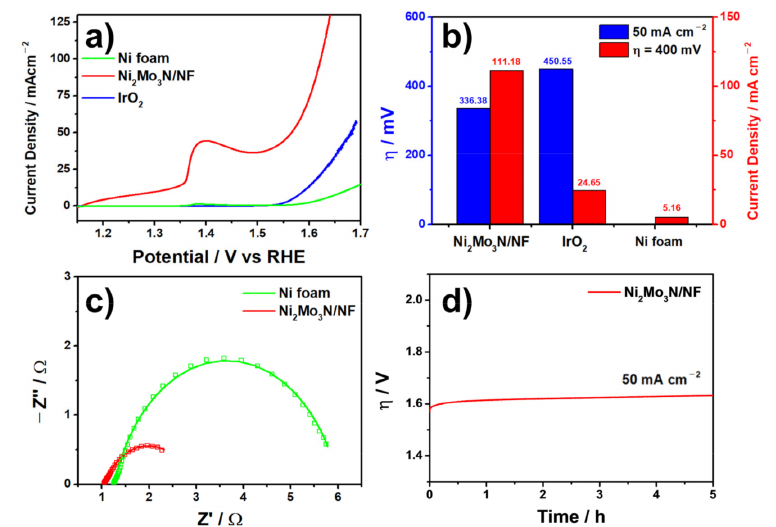
Figure 3. Electrochemical characterization of the prepared catalysts. ( a ) Polarization curves (1.0 M KOH solution), ( b ) bar graphs showing overpotentials at 50 mA cm − 2 and current densities at an overpotential of 400 mV, ( c ) Nyquist plots, and ( d ) durability